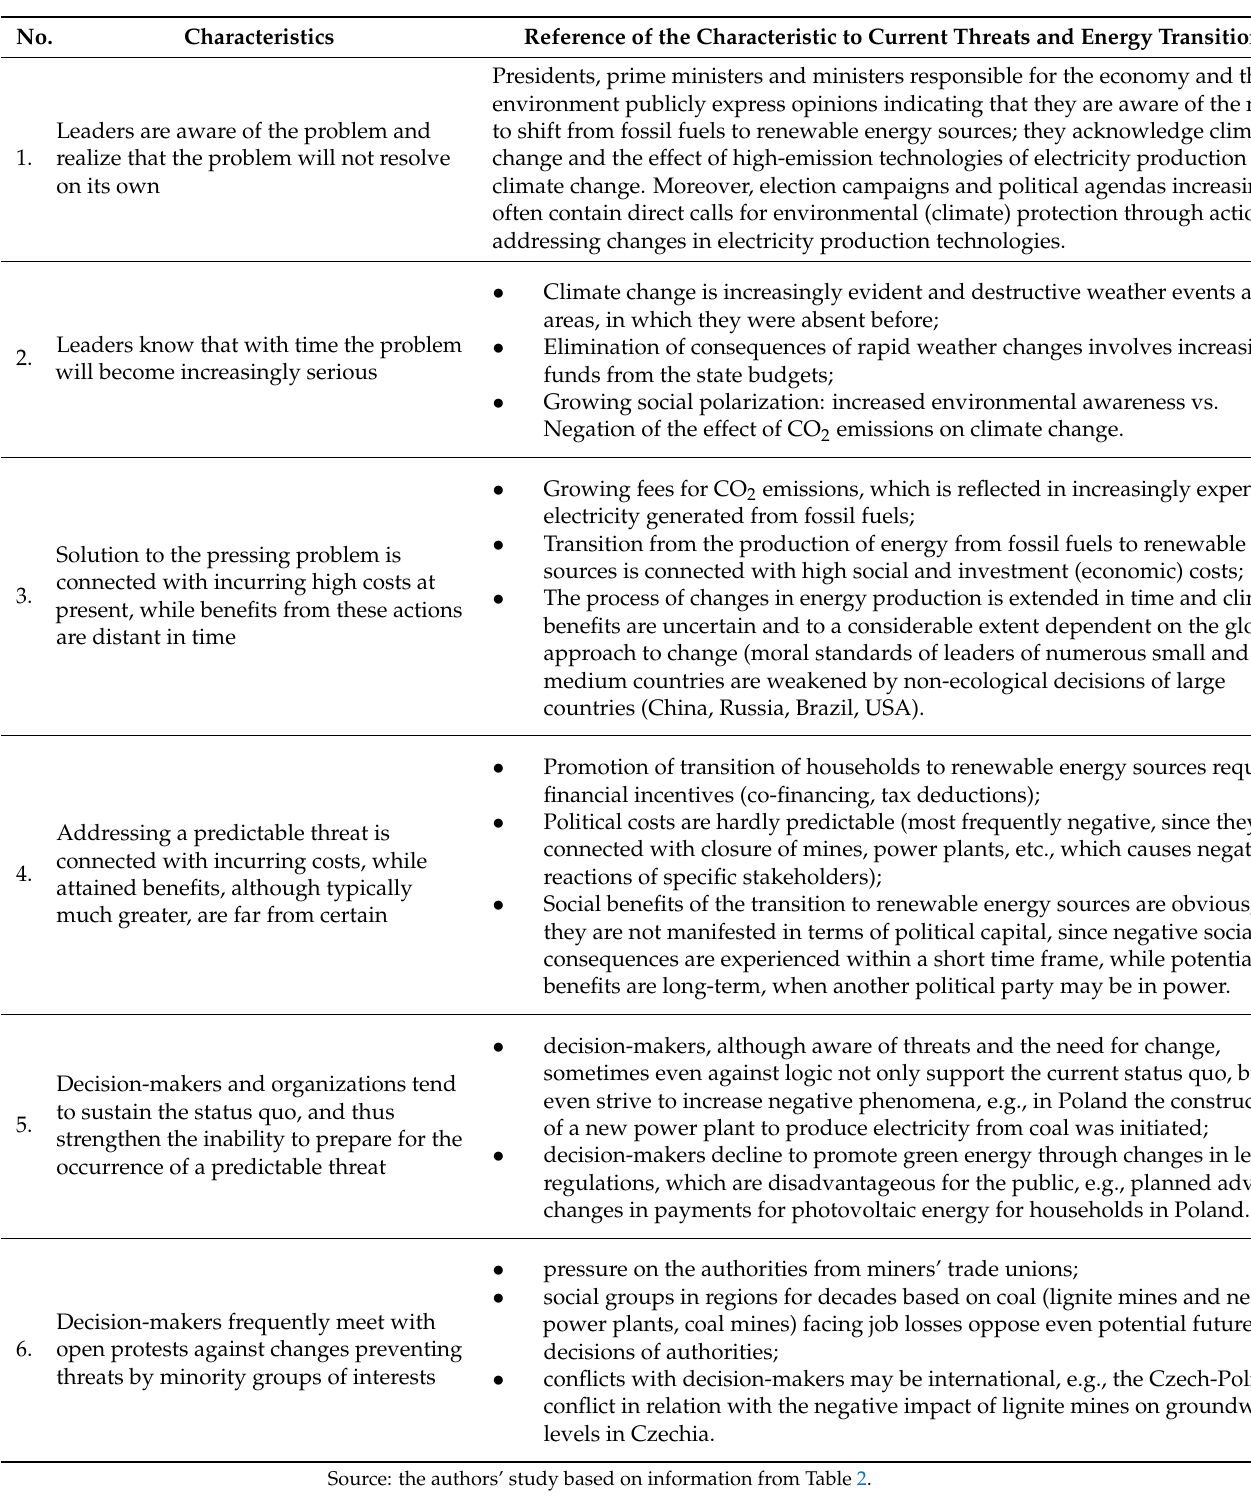
Table 5. Six characteristic features of predictable threats and threats concerning energy